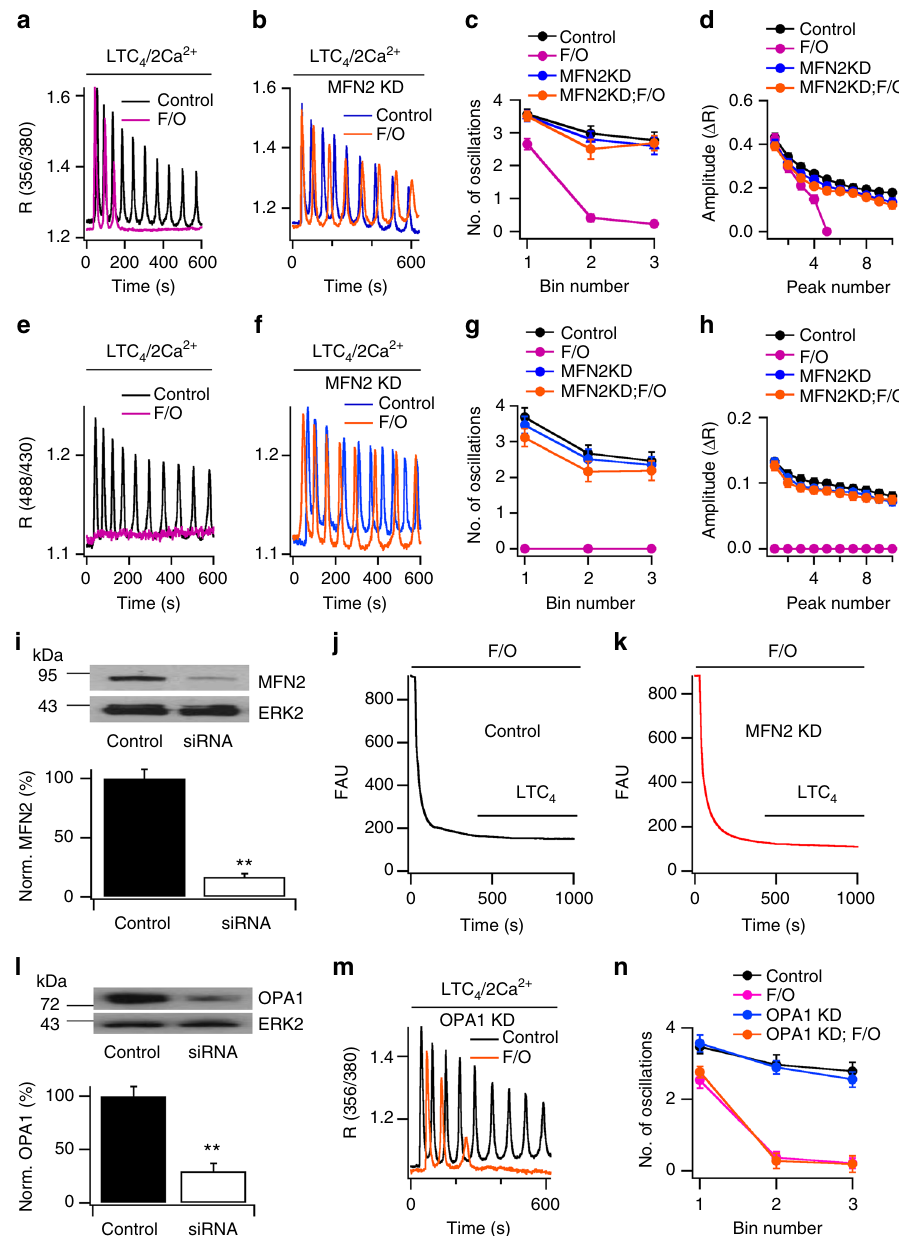
Fig. 1 Mitofusin 2 knockdown rescues oscillatory Ca 2+ signals in cells with de-energised mitochondria. a Cytosolic Ca 2+ oscillations (measured with fura 2) to LTC 4 (120 nM) are suppressed by FCCP (2 μ M) and oligomycin (0.5 μ g per ml; depicted as F/O), pre-treated for 5 – 10 min. b Mitofusin 2 knockdown has little effect on cytosolic Ca 2+ oscillations in a cell with energised mitochondria but sustains the response in a cell pre-treated with FCCP and oligomycin. c The number of oscillations in each 200 s bin (measured from the application of LTC 4 ) are compared for the conditions shown. Each point is the mean of 15 – 20 cells from three independent experiments. Control trace (black) is offset upwards by 0.1, to resolve it from other traces. d Oscillation amplitude is plotted against oscillation number. A peak number of 4 denotes the fourth oscillation. Control trace (black) is offset upwards by 0.04. e Matrix Ca 2+ oscillations measured with the mitochondrially targeted pericam are shown for a control cell challenged with LTC 4 and for one pre-treated with FCCP and oligomycin. f Matrix Ca 2+ oscillations are compared in the absence and presence of FCCP, following mitofusin 2 knockdown. g , h The number of matrix Ca 2 + oscillations ( g ) and the amplitude of each oscillation ( h ) are compared for the conditions shown. Each point is the mean of > 14 cells from three independent experiments. In panel g , the control trace (black) is offset upwards by 0.1. i Western blot compares mitofusin 2 expression in control cells and after siRNA-targeted knockdown. The histogram summarises aggregate data from two separate samples. j , k Mitochondrial membrane potential, measured with TMRE, is shown following exposure fi rst to FCCP and oligomycin and then LTC 4 in a control cell ( j ) and in one following mitofusin 2 knockdown ( k ). FAU denotes fl uorescence, arbitrary units. l Western blot compares OPA1 protein expression in control cells and after siRNA-targeted knockdown. m OPA1 knockdown does not rescue cytosolic Ca 2+ oscillations in FCCP-treated cells. n Number of Ca 2+ oscillations per 200 s bin are compared for the conditions shown. All data are from RBL-1 mast cells. ** p < 0.01 (unpaired Student ’ s t -test). Error bars denote